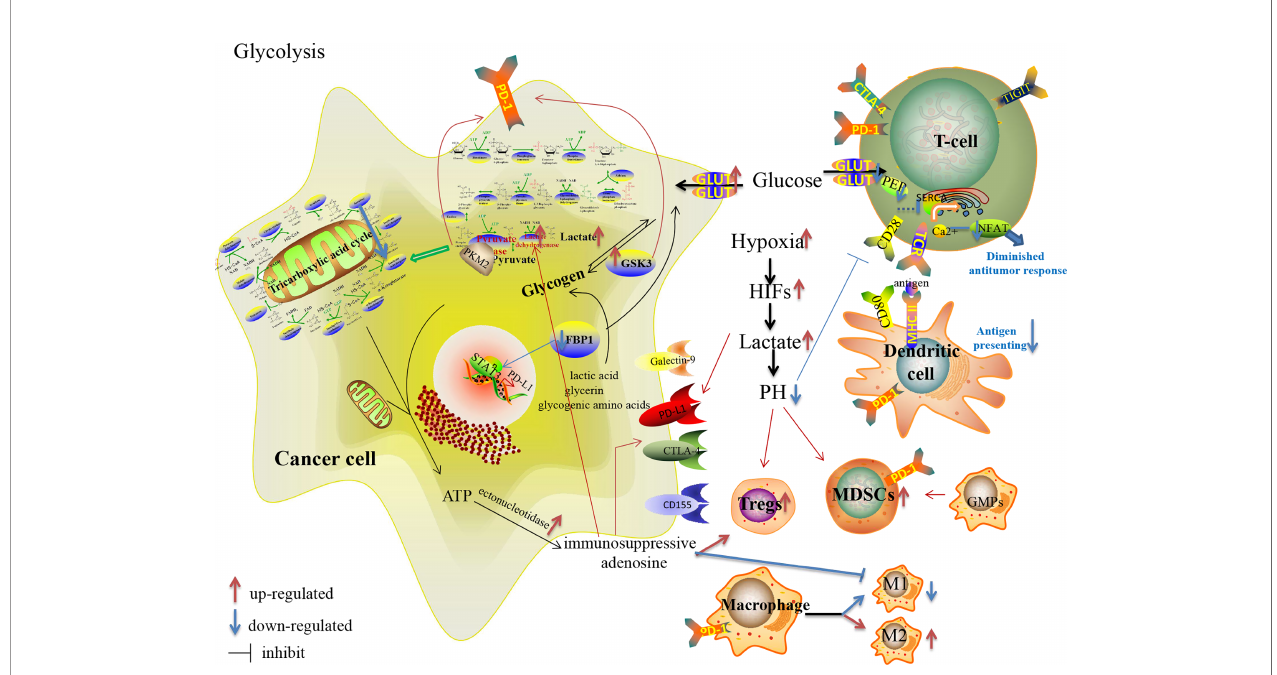
FIGURE 1 | Glucose metabolism reprogramming in cancer cells and immune cells in the TME, and their effects on the expression of immune